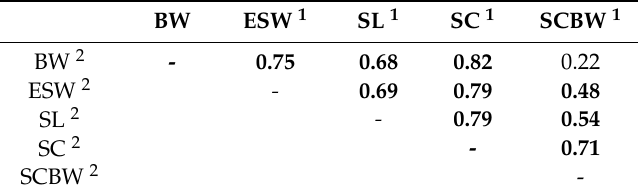
Table 2. Correlations between stomach